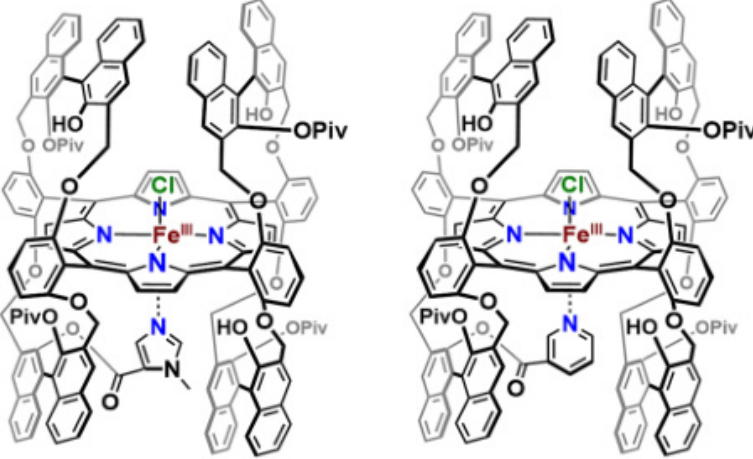
Figure 6. “Twin-coronet” model systems with tethered axial N-based ligands. Reprinted with permission from Ref. [15]. Copyright 2018, American Chemical Society.